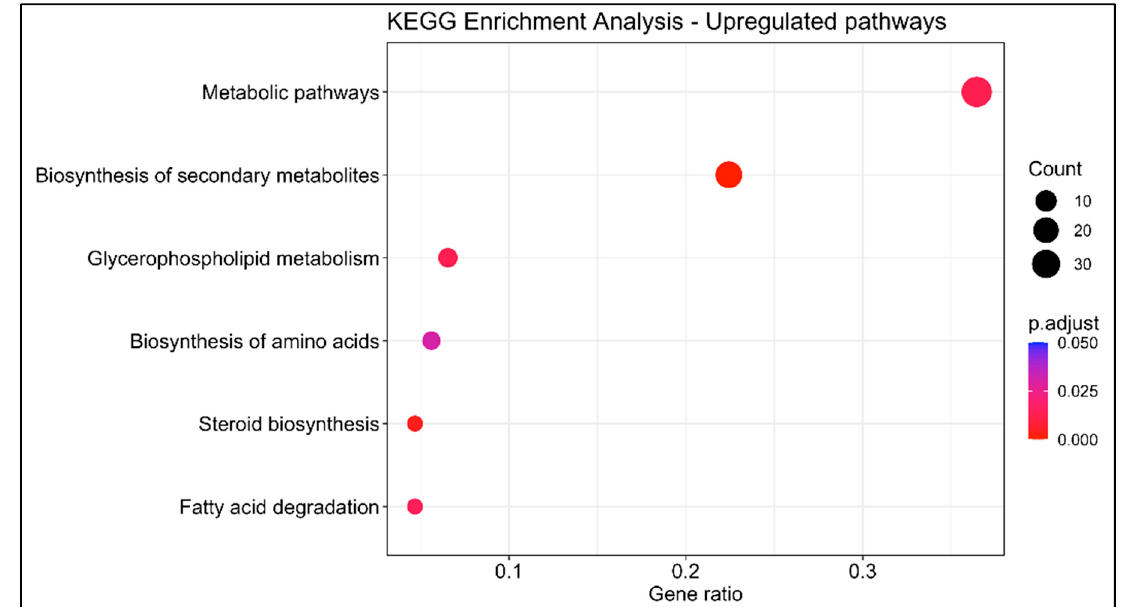
Figure 6. KEGG BRITE functional hierarchies analysis category B (intermediate category). The bar plot shows on x -axis the number of DEGs per intermediate category between livers of immature ( n = 3) and mature ( n = 3) females; y -axis indicates the pathway description.